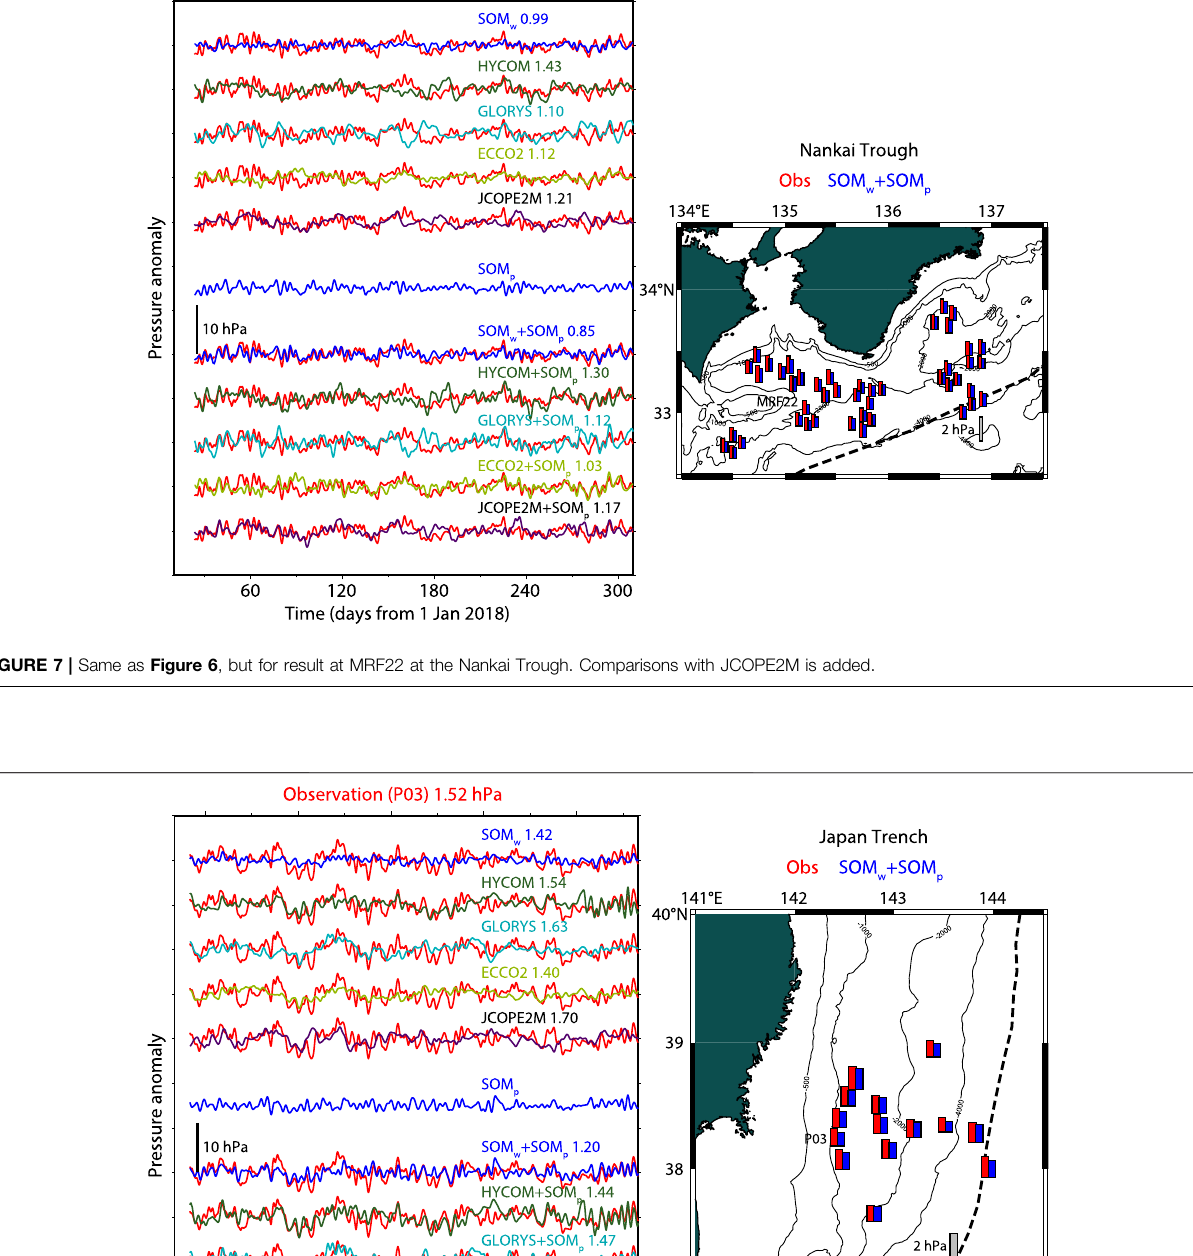
Frontiers in Earth Science |